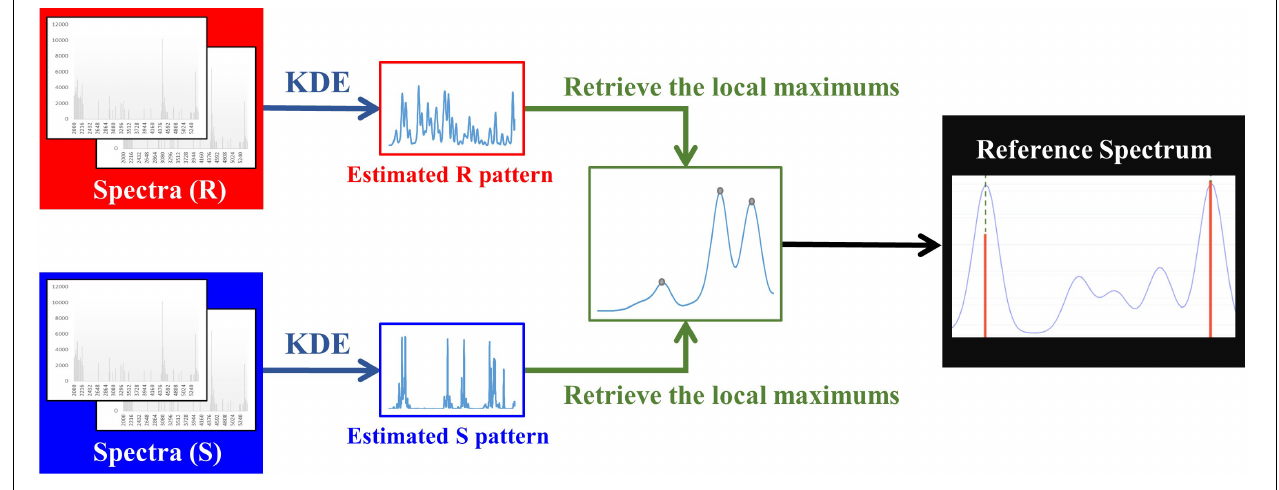
FIGURE 1 | Flow chart of constructing a reference spectrum